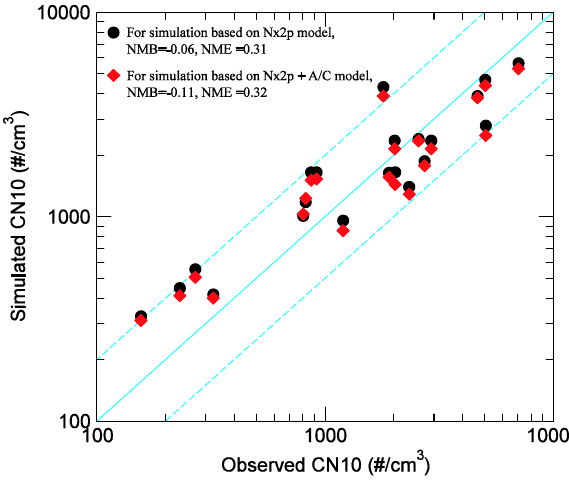
Figure 9. Fig. 9. Comparison of annually averaged number concentrations of CN10 observed at 21 sites shown in Fig. 8a with those simulated with N × 2p and N × 2p+A/C SOA formation models. The solid line shows a 1:1 ratio, and the dashed lines show ratios of 2:1 and